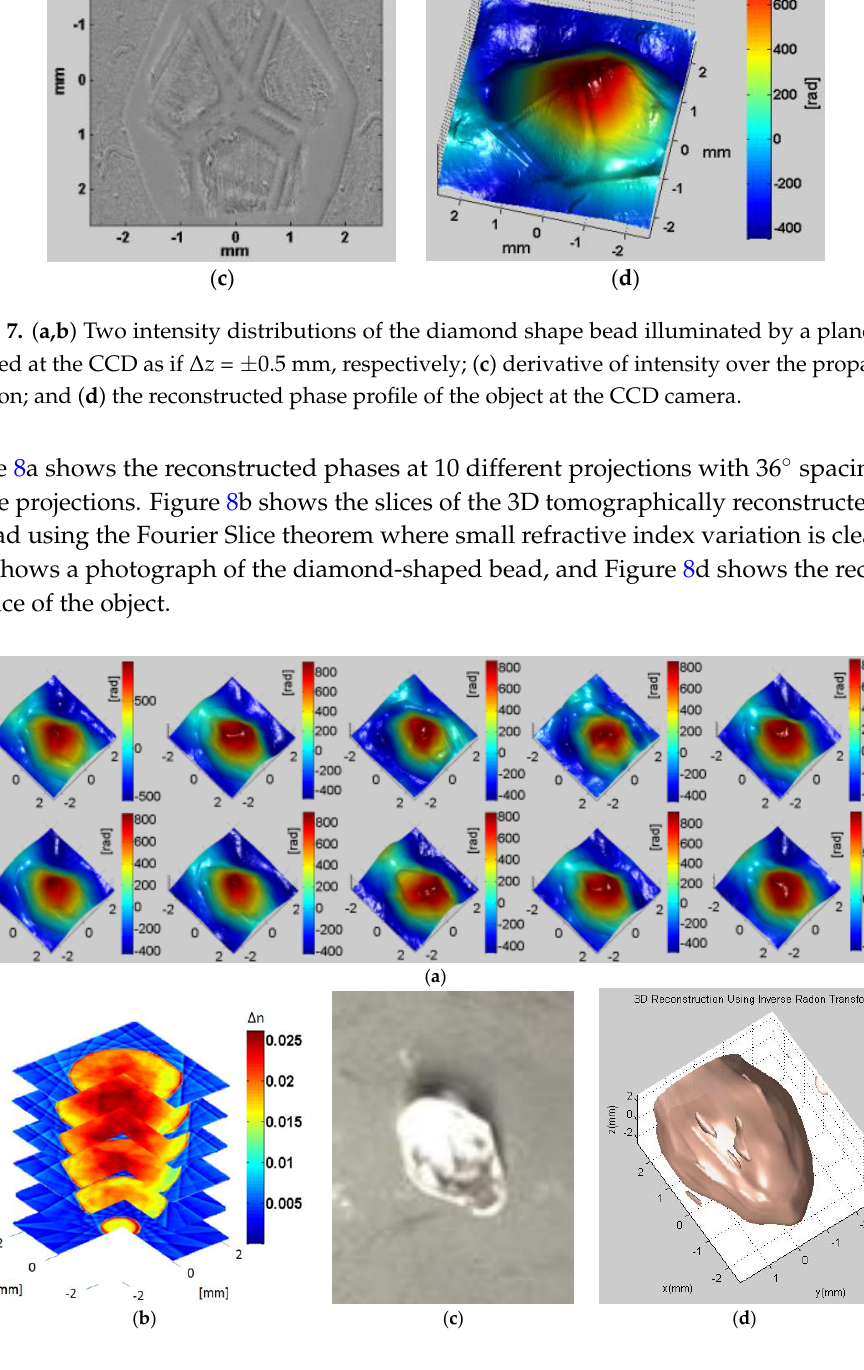
( f ) Figure 9. ( a – c ) Intensity distributions of dried pine pollen cells at 𝛥 z = 1, 0, −1 mm; ( d ) Derivative of intensity images over the propagation direction; ( e ) Height distribution converted from phase [7]; ( f ) Pine pollen image seen under a bright field microscope.